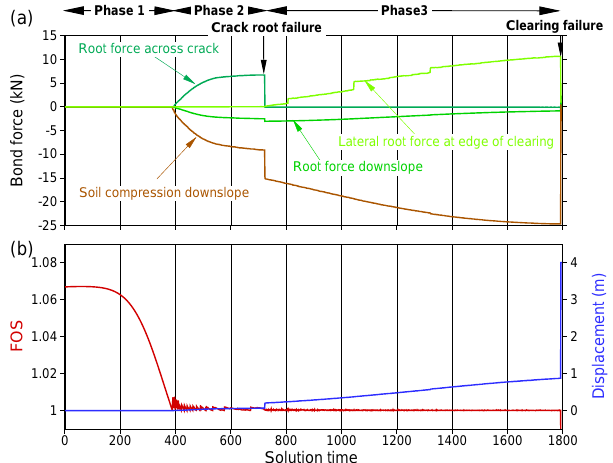
Figure 20. Evolution of (a) soil and root bond force, and (b) factor of safety and displacement during the initiation of a landslide in a forested hillslope (simulation 50/30 described earlier) at the center of the